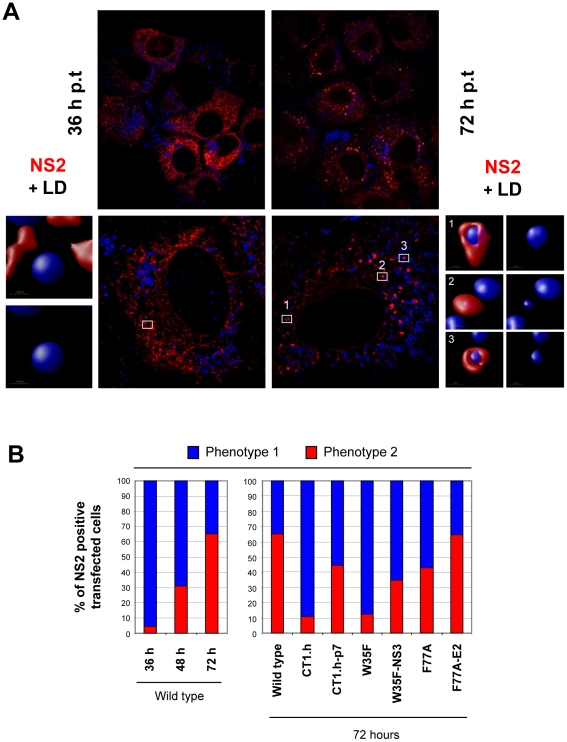
Time-dependent change of NS2 subcellular localization.Huh7-Lunet cells were transfected with JFH1mut4-6 HAF-NS2 and 36, 48 and 72 h later, NS2 and LDs were detected by using an HA-specific antibody (red) or BODIPY staining (blue), respectively. (A) Representative images of cells 36 and 72 h p.t. (left and right half, respectively). An overview is shown in the top, a magnification of a single cell from a different view field below. Boxed areas are enlarged in the smaller panels to the left and right, respectively. Enlargements show 3D reconstructed images created with the Volocity 5.3 software. In case of the 72 h value 3 representative structures are displayed. The staining pattern shown for the 36 h time point and in panel 2 for the 72 h time point corresponds to phenotype 1. (B) Huh7-Lunet cells were transfected with the wild type (left panel) or given NS2 mutants (right panel) and analyzed as described above. Shown are the ratios of phenotype 1 and 2. In case of the wild type values determined at different time points after transfection are shown, in case of the mutants only the values measured 72 h p.t. For each construct, 180 cells were analyzed.